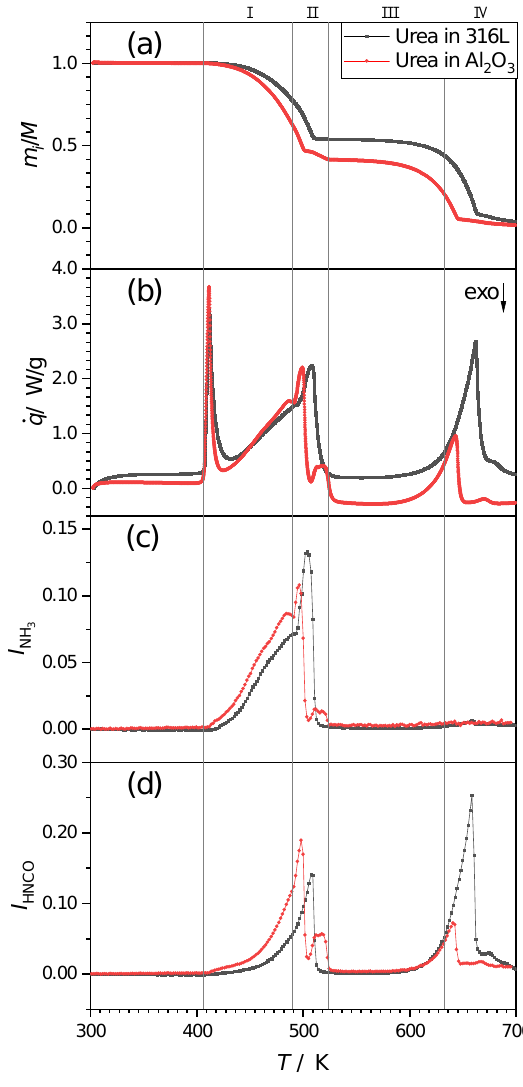
Figure 7. Urea pyorolysis in AISI-316L and Al 2 O 3 crucibles heated at 5K/min under N 2 . ( a ) TGA results. ( b ) DSC results; ˙ q denotes specific heat flow. ( c ) GP-FTIR data; I NH of NH 3 at 965cm − 1 . ( d ) GP-FTIR data; I HNCO is the measured intensity of HNCO at 2283cm − 1